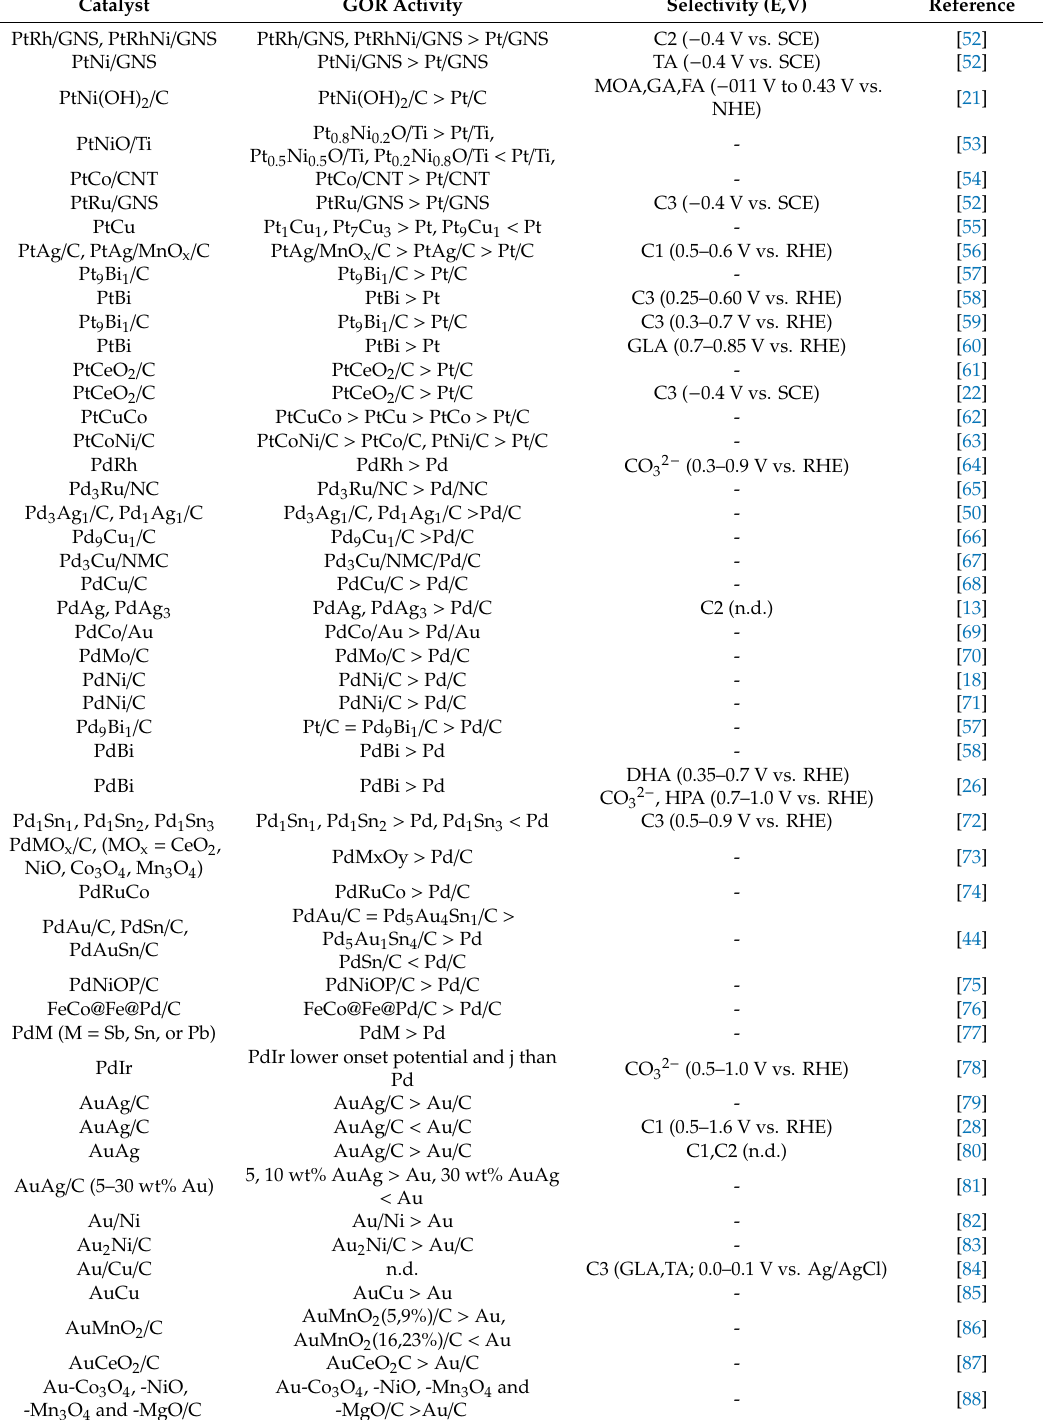
Table 2. GOR activity and selectivity in alkaline media of binary and ternary Pt-, Pd- and Au-based catalysts.